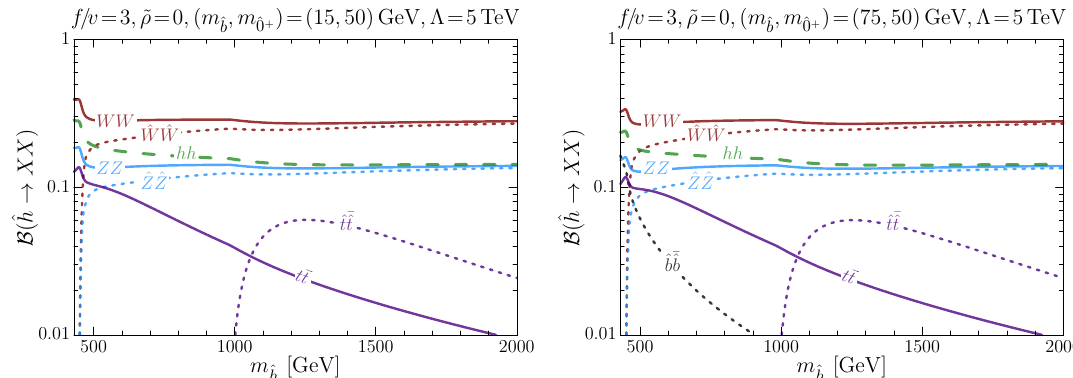
Figure 8 . These plots show branching ratios of heavy twin Higgs to di(cid:11)erent (cid:12)nal states as a function its mass in the FTH model. The left and right plots are for ( m ^